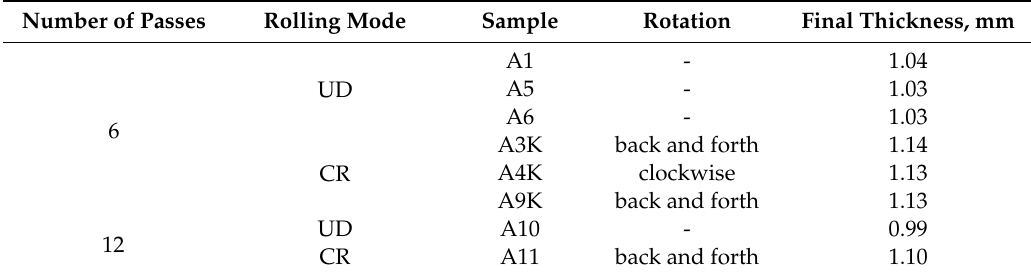
Table 1. The investigated samples and their properties. UD: unidirectionally; CR: cross-rolled. Number of Passes Rolling Mode Sample Rotation Final Thickness, mm A1 - 1.04 A5 - 1.03 UD A6 - 1.03 6 A3K back and forth 1.14 A4K clockwise 1.13 CR A9K back and forth 1.13 UD A10 - 0.99 12 CR A11 back and forth